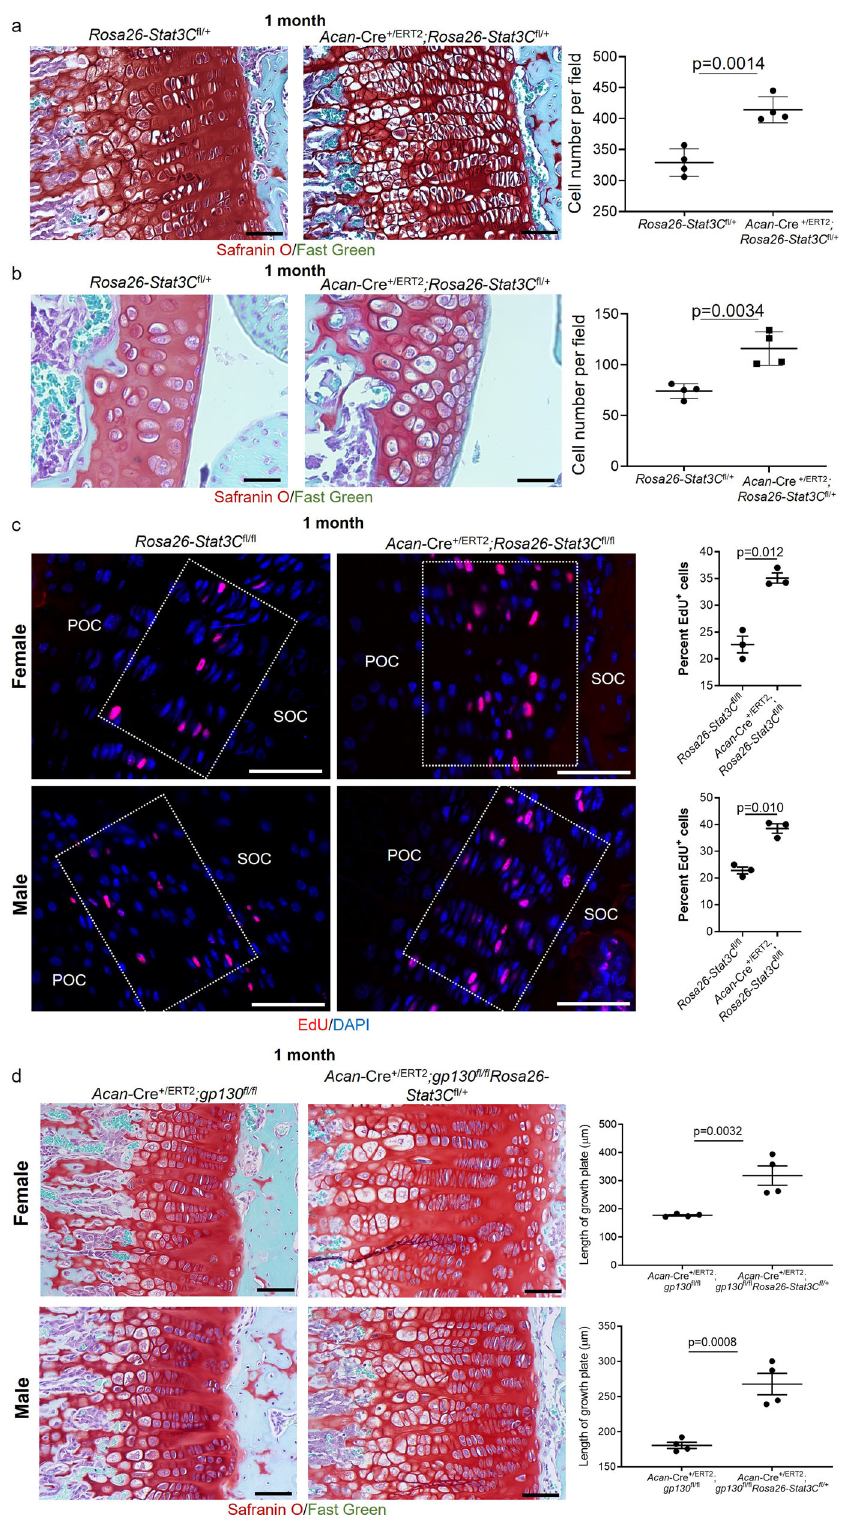
Fig. 9 Overexpression of constitutively active Stat3 (Stat3C) in chondrocytes promotes precocious proliferation in vivo and rescues growth plate defects in gp130 deletion mutants. Induction of Stat3C expression at P2/P3 resulted in signi fi cant increases in chondrocyte number in both growth plate ( a ) and articular cartilage ( b ) in Acan -Cre + /ERT2 ; Rosa26 -Stat3C fl / + mice as compared to Rosa26 -Stat3C fl / + control animals at 1 month. c EdU was injected intraperitoneally 4h before harvesting knee joints at 1 month of age. EdU + cells in proximal tibial growth plate chondrocytes were scored. POC primary ossi fi cation center, SOC secondary ossi fi cation center. Boxed areas delineate the growth plate. d Induction of constitutively active Stat3 in Acan -Cre + /ERT2 ; gp130 fl / fl mice resulted in signi fi cantly thicker growth plates at 1 month of age. In all panels, scale bars = 50 µ m; n = 4 – 6 for each